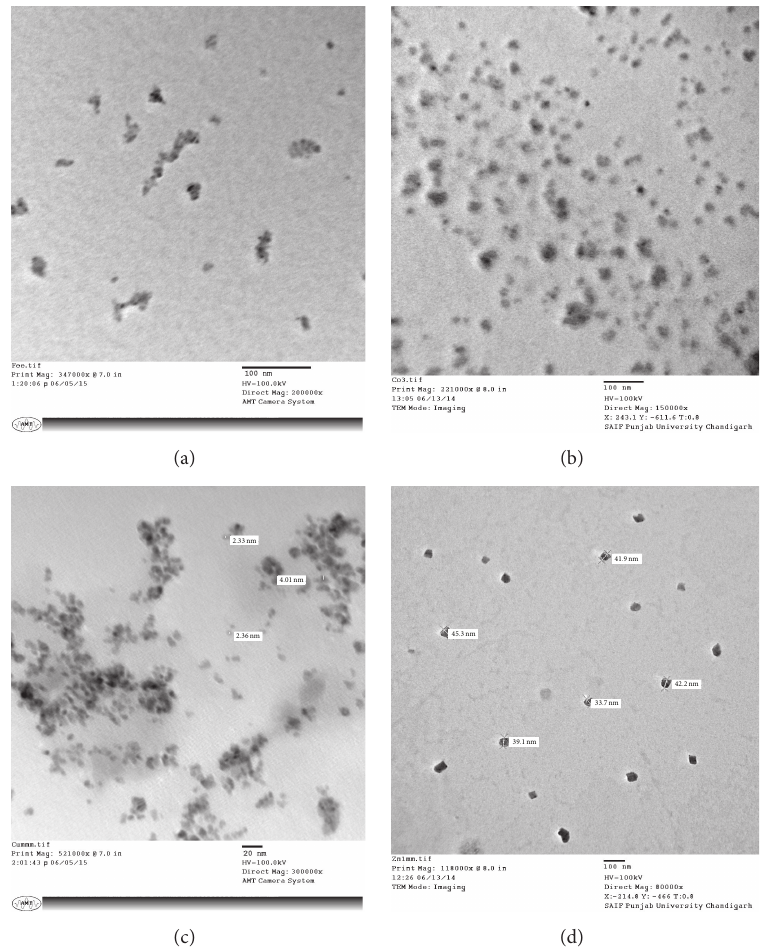
Figure 5: TEM images of (a) FeHCF, (b) KCoHCF, (c) KCuHCF, and (d) KNiHCF nanoparticles.